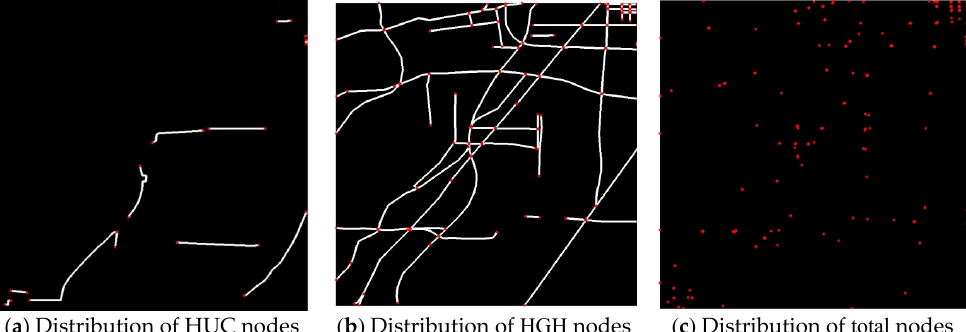
Figure 3. The distribution of the nodes in the study area.